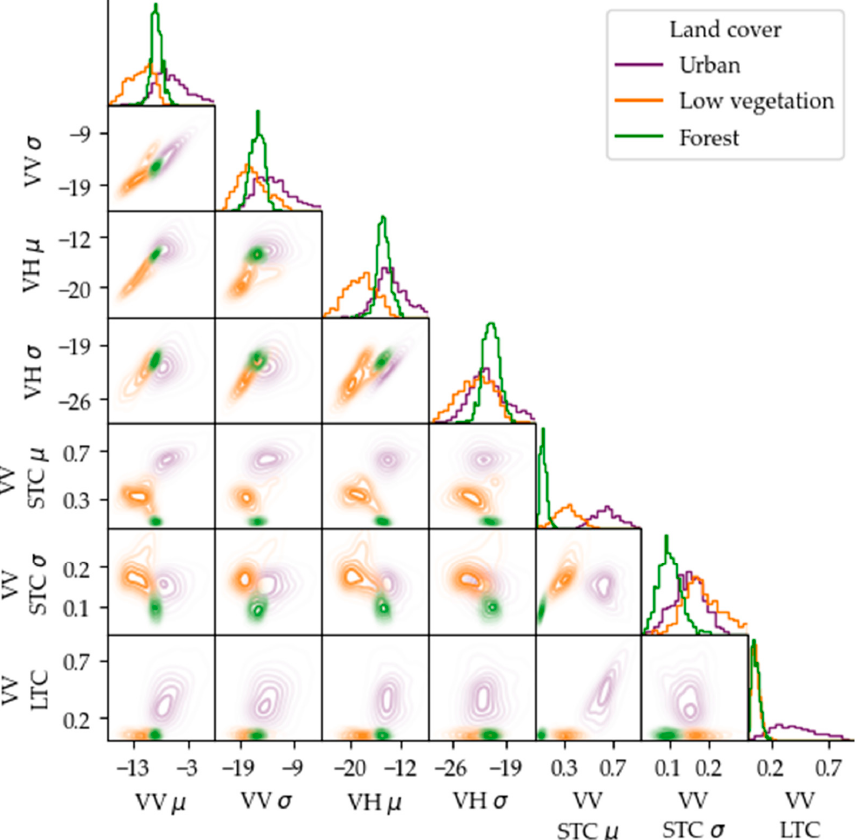
Figure 3. Value distribution of a subset of 1000 random pixels extracted from the training sample at the temperate site. The diagonal displays histograms, the remaining cells display the 2D kernel density estimate for each pair of variables. Water cover has been excluded to improve visibility for the remaining classes. STC stands for “short-term coherence” whereas LTC stands for “long term coherence”. Note that backscattering intensity annual statistics were calculated in linear scale and then converted to decibel (dB).